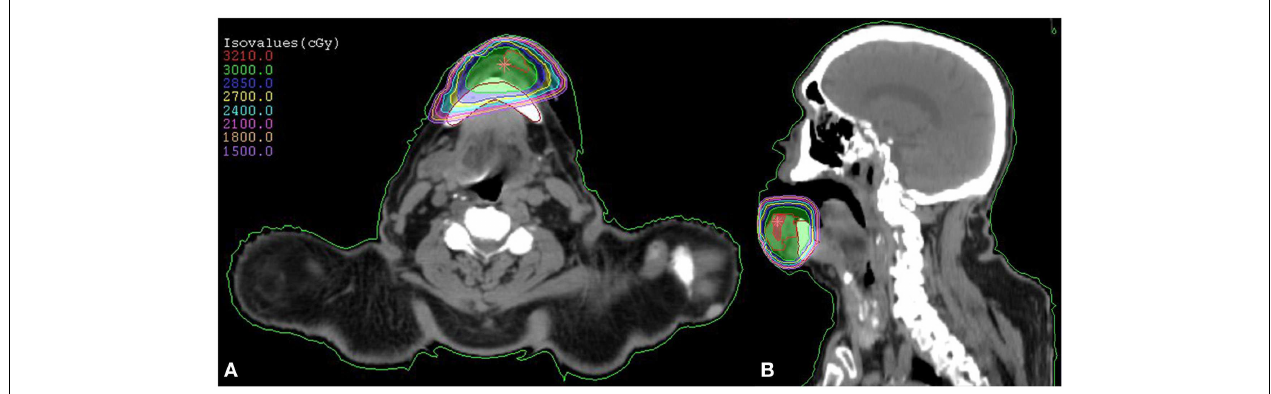
FIGURE 1 | SBRT dose plan for our patient with squamous cell carcinoma of the lower lip demonstrated by an axial (A) and coronal (B) view .The prescribed treatment dose of 3000cGy is demonstrated in green.